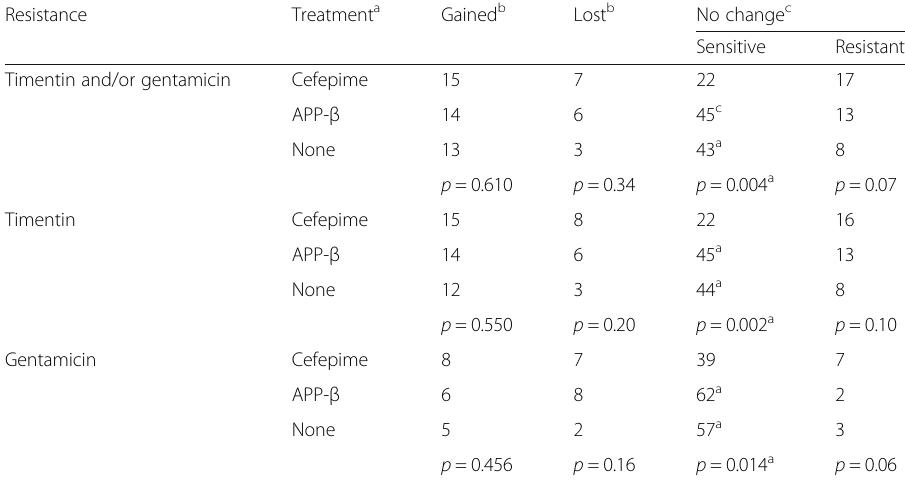
Sensitive Resistant